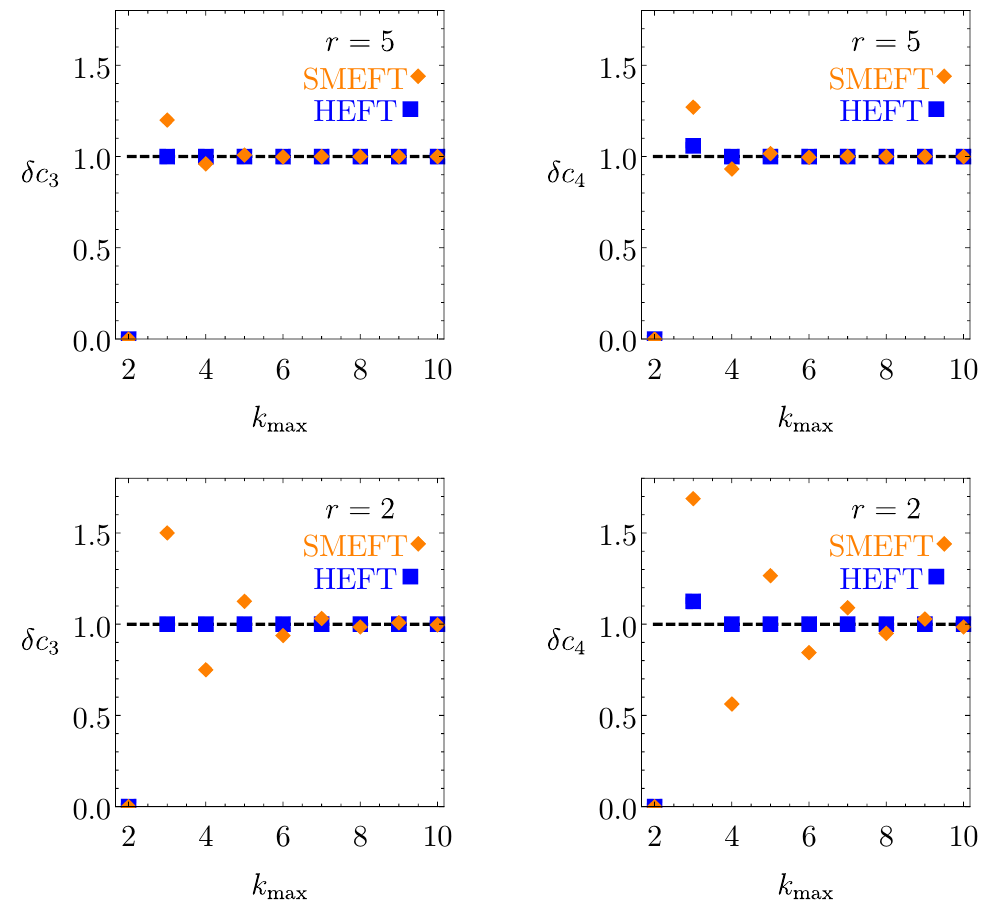
Figure 6 . Corrections to the Higgs trilinear (left panels) and quartic (right panels) couplings ex- tracted from truncated SMEFT (orange diamond) and HEFT (blue square) expansions, normalized to the actual all-order prediction in eq. (8.14). The upper (lower) panels are for r = 5 ( r = 2 ), see eq. (8.9) for the